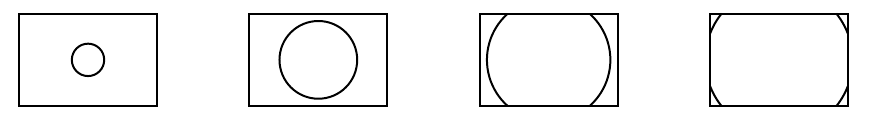
Figure 8. T 2 as rectangle with opposing edges identified, with a sequence of entangling regions of increasing size (showing sections at x = 0 , as described in the text). From left to right: the cap phase, the bridge phase associated with the shorter cycle where the bridge extends across the horizontal edges, the bridge phase associated with the longer cycle where the bridge extends along the vertical edges, and the transition towards filling in the torus completely where the bridge fills in the